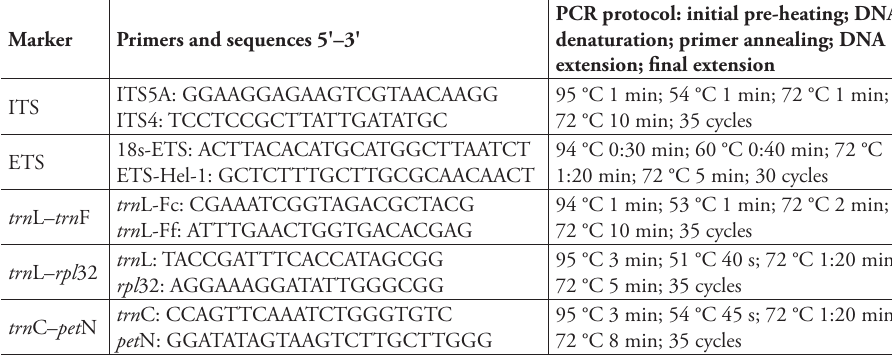
Table 3. Amplification protocols for all markers.